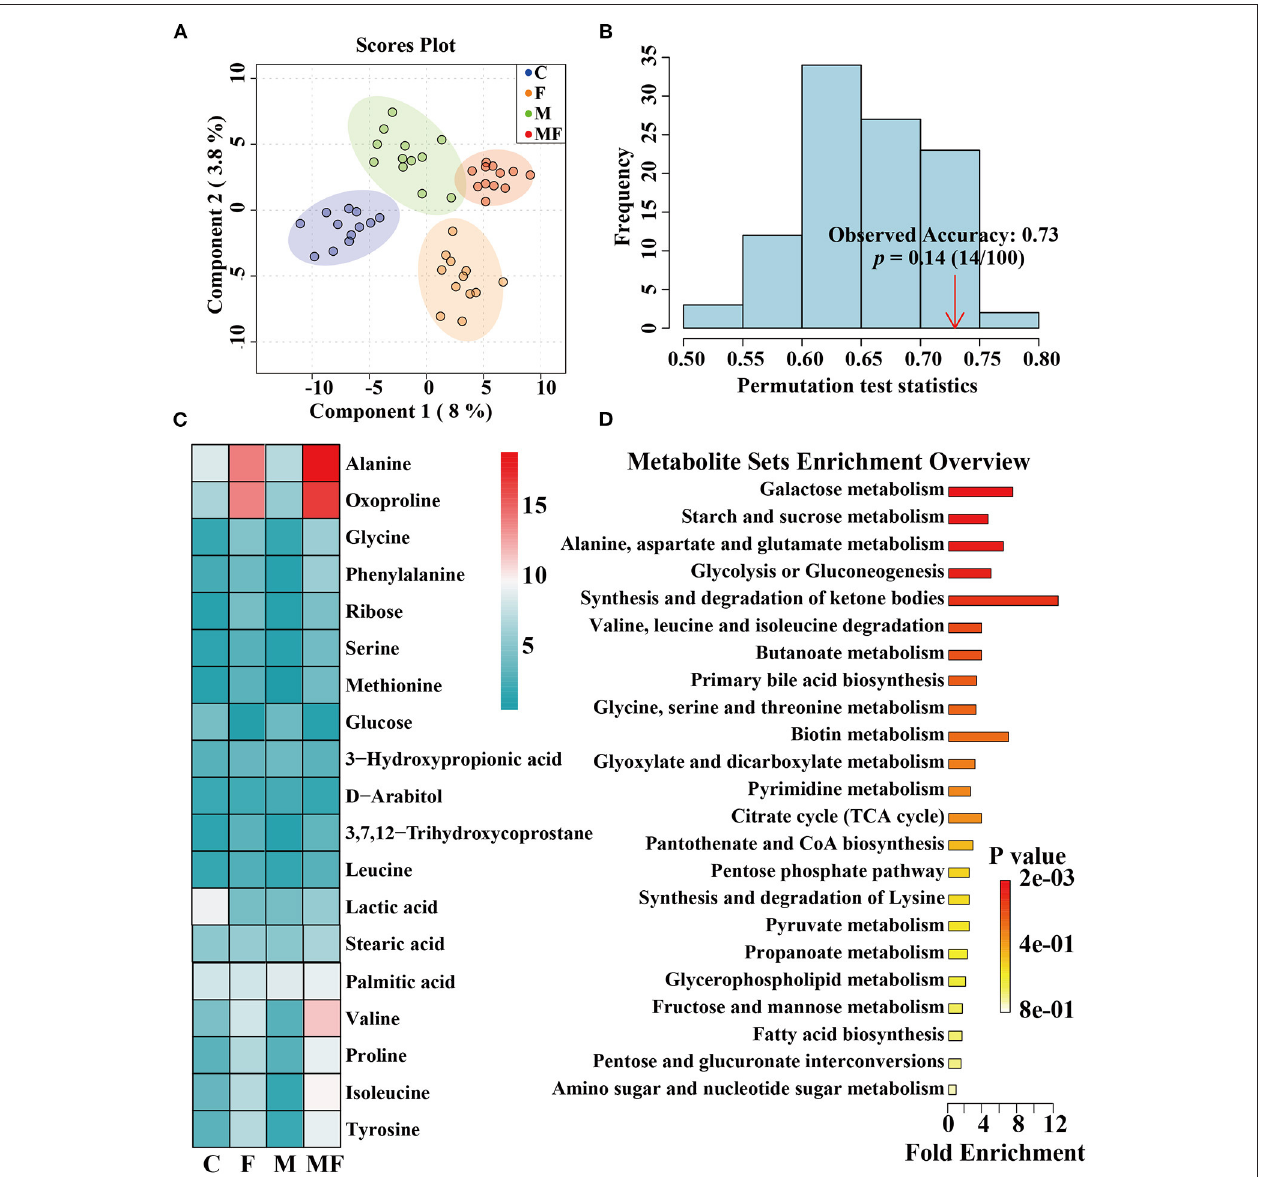
FIGURE 8 | The effects of intermittent fasting and melatonin supplementation on intestinal metabolites in mice. (A) Score plot from and PLS-DA of metabolite profiles of the intestinal contents of mice between all groups. Each data point represents a function of the entire spectral profile of each subject; (B) The permutation test was evaluated based on the corresponding PLS-DA model. (C) A heatmap of significantly altered metabolites in the intestines of mice between all groups. (D) Metabolic pathways related to each metabolite. Data are presented as mean ± SEM, n = 12. C, control; F, intermittent fasting; M, melatonin; MF, intermittent fasting plus melatonin. The C and M mice were fed ad libitum , while the F and MF groups underwent alternative-day feed deprivation. The M and MF groups mice were supplemented with melatonin at a dose of 10 mg/kg body weight by